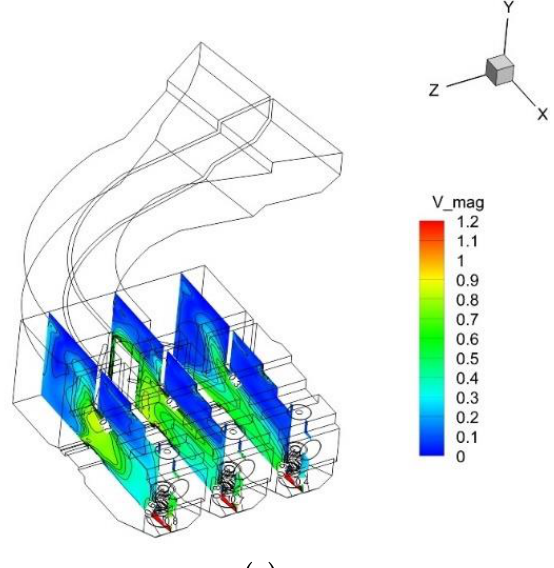
Figure 13. Plan 5 Isogram of velocity. ( a ) Center section of pump body along flow direction. ( b ) Center section of pump body in vertical flow direction.